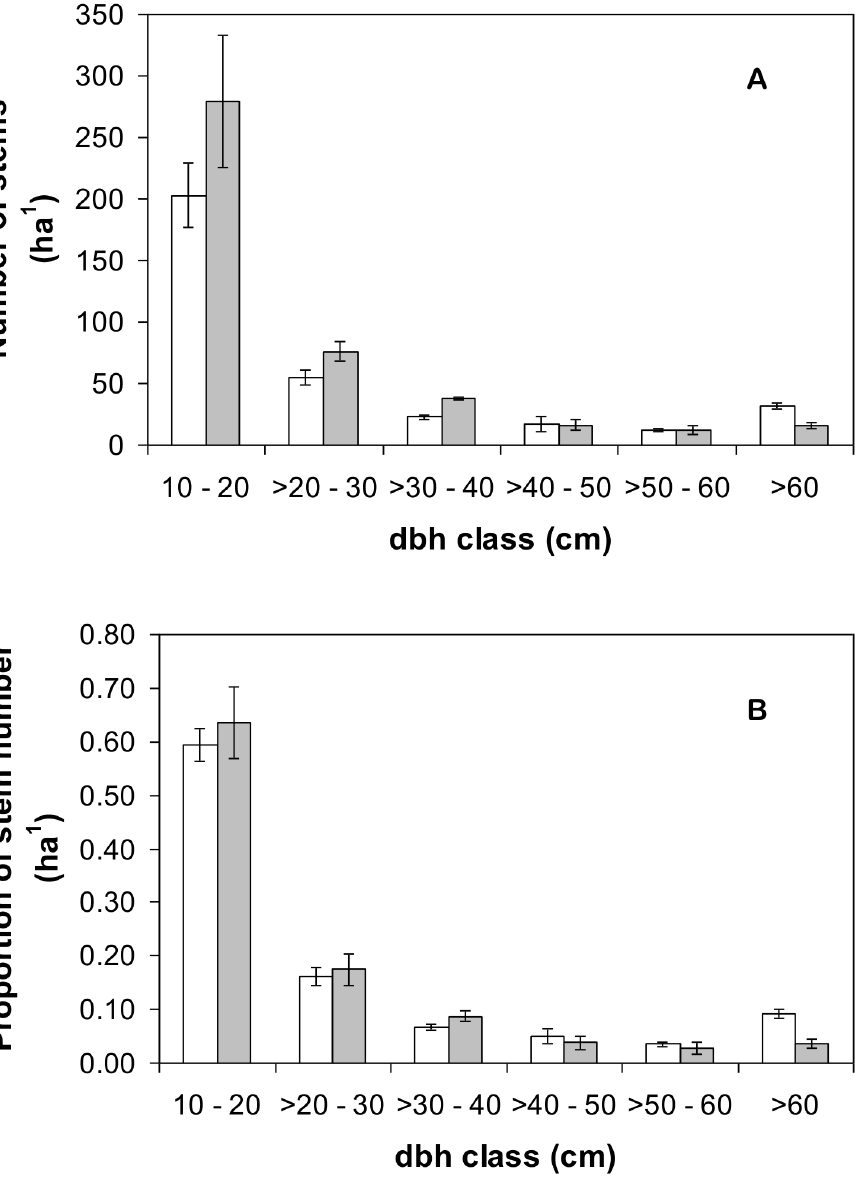
Figure 2. Allocation of number of stems (A) and proportion of stem number (B) in different diameter in breast height (dbh) classes in monodominant Gilbertiodendron forests (white bars) and mixed forests (grey bars). Error bars represent 95% confidence intervals.